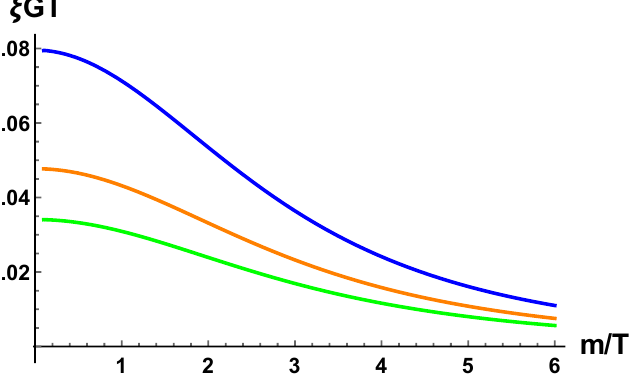
Figure 4 . The value of the (cid:24) parameter (3.4), opportunely made dimensionless using the shear modulus G and the temperature T , as a function of the SSB parameter m=T for N = 3 ; 4 ; 5 (from blue, top; to green,